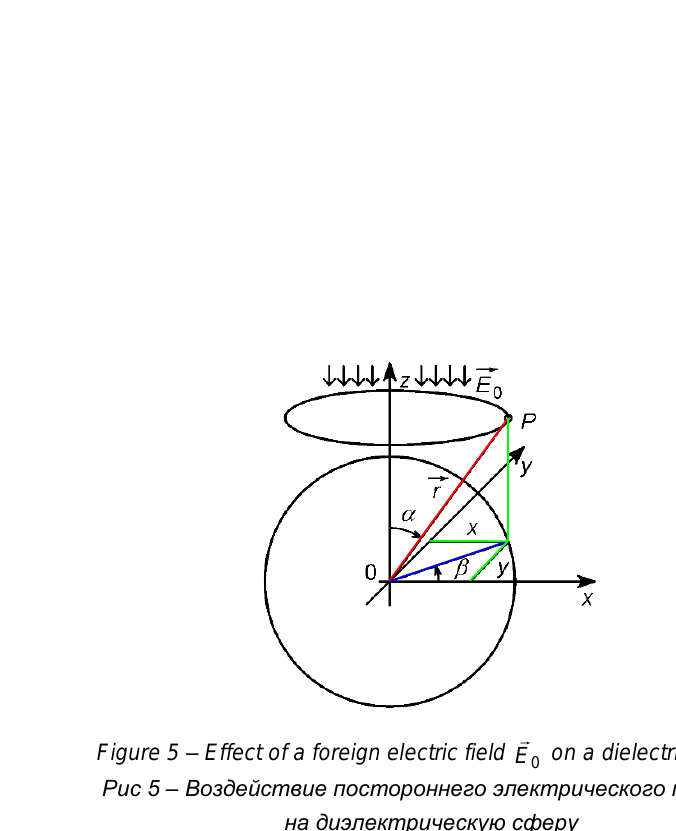
на диэлектрическую